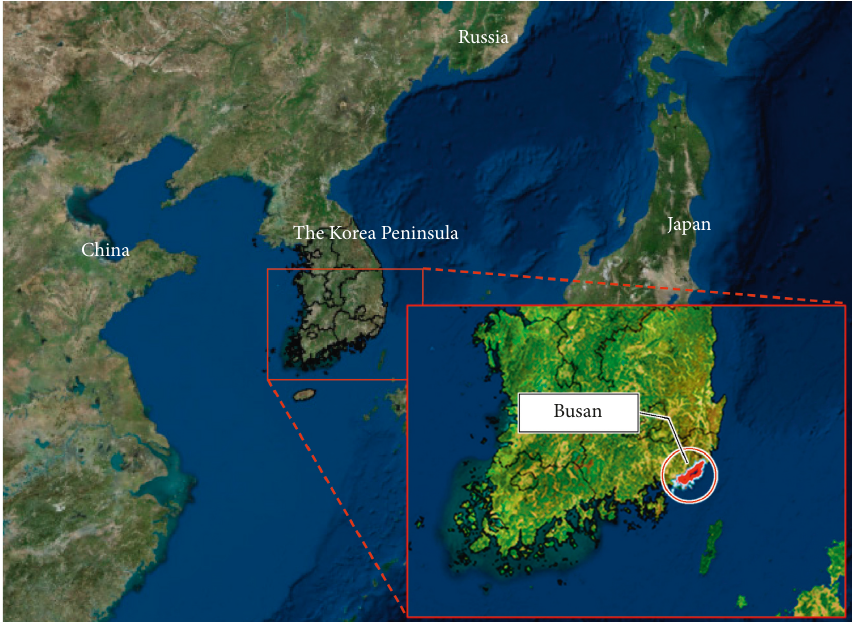
Figure 5: Location of Busan metropolitan.